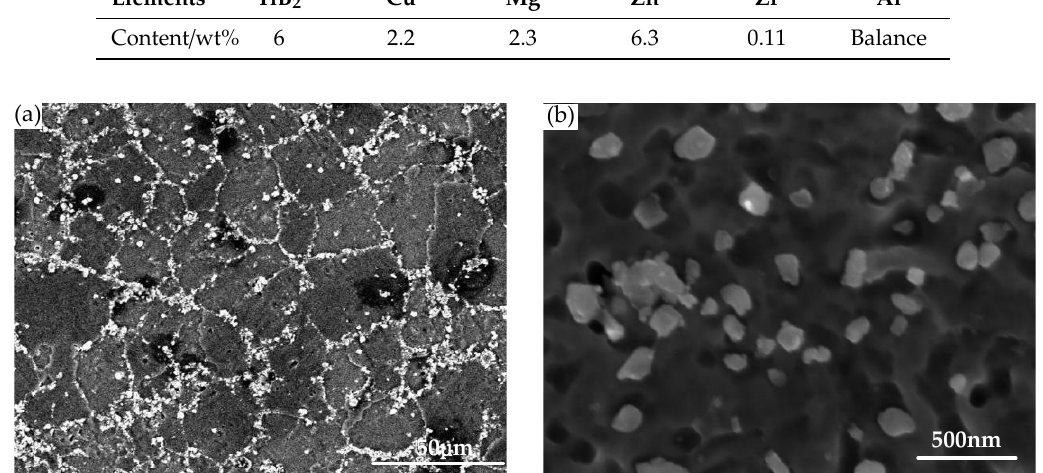
Figure 1. Microstructure of TiB 2 /7050 Al composite: ( a ) SEM images shows the distribution of TiB 2 particles; ( b ) Magnified TiB 2 particles aggregated along the grain boundaries. Table 1. Nominal chemical composition of TiB 2 /7050 Al composite.